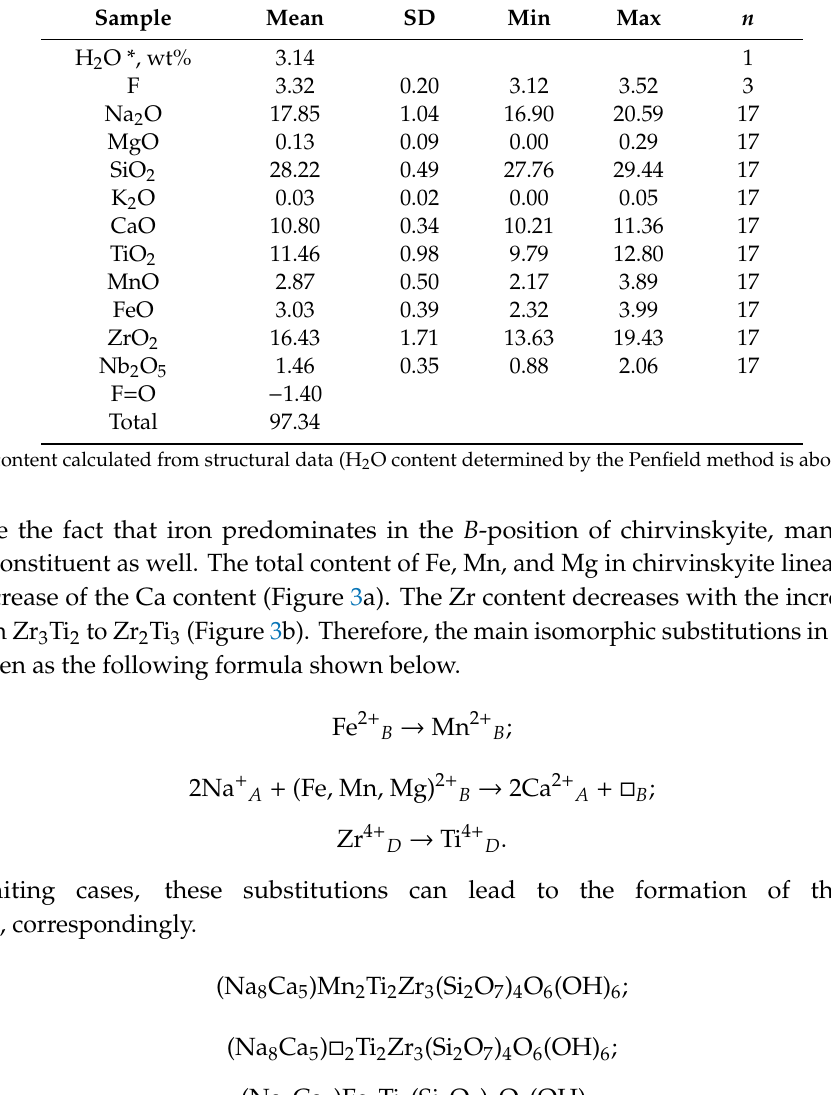
Table 1. Chemical composition of